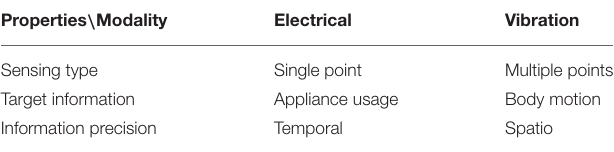
TABLE 1 | Complementary sensing